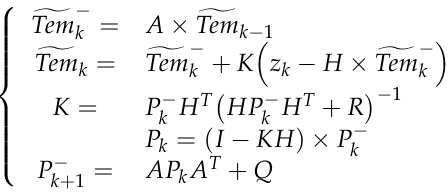
Figure 7. Statistics on the quantitative relationship of errors in raw temperature